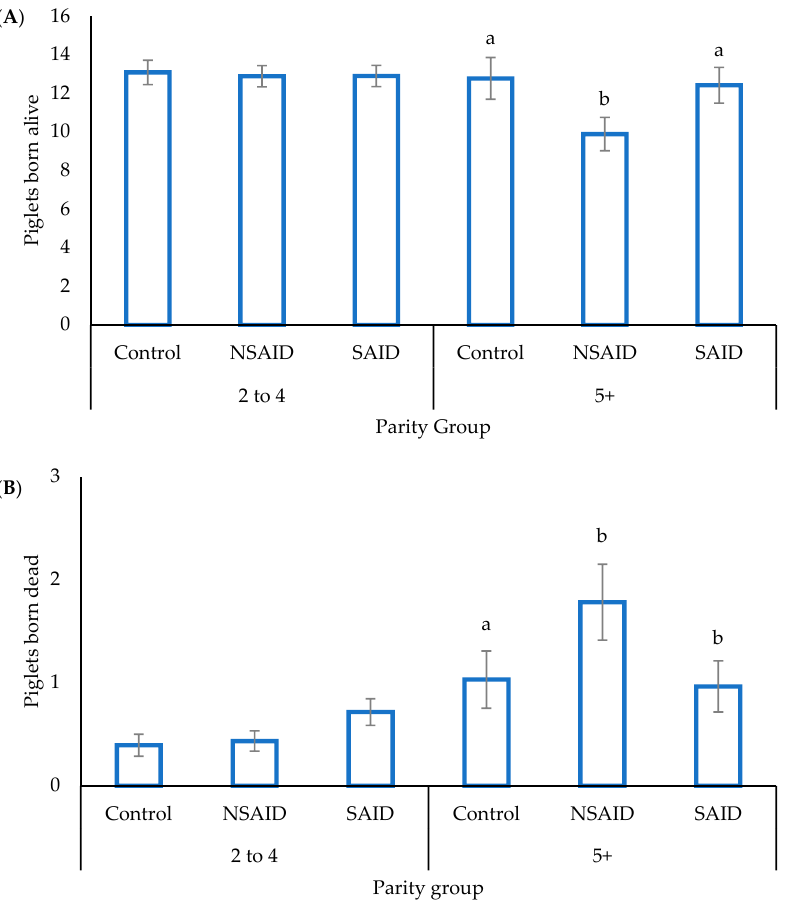
Figure 1. The effect of saline (Control), a non-steroidal anti-inflammatory (NSAID), or steroidal anti-inflammatory (SAID) administration prior to farrowing on the number of piglets born alive ( A ) and dead ( B ) per litter (mean ± SEM) for sows of parity 2 to 4 or 5+. a,b represents a significant difference ( p < 0.05) within parity group. The main effect of treatment did not affect facial injury score ( p > 0.05). However, within parities 2 to 4, SAID sows presented with a lower score than Control, with NSAID sows intermediate (Figure 2; p < 0.05)